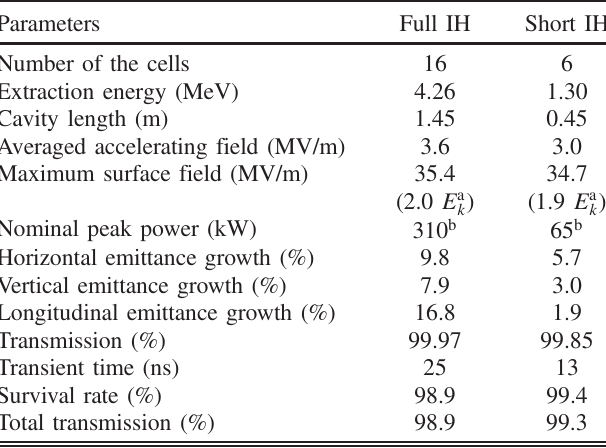
FIG. 4. Simulated on-axis EM fields of the short IH at the nominal voltage. The average accelerating field is 3 . 0 MV = m.